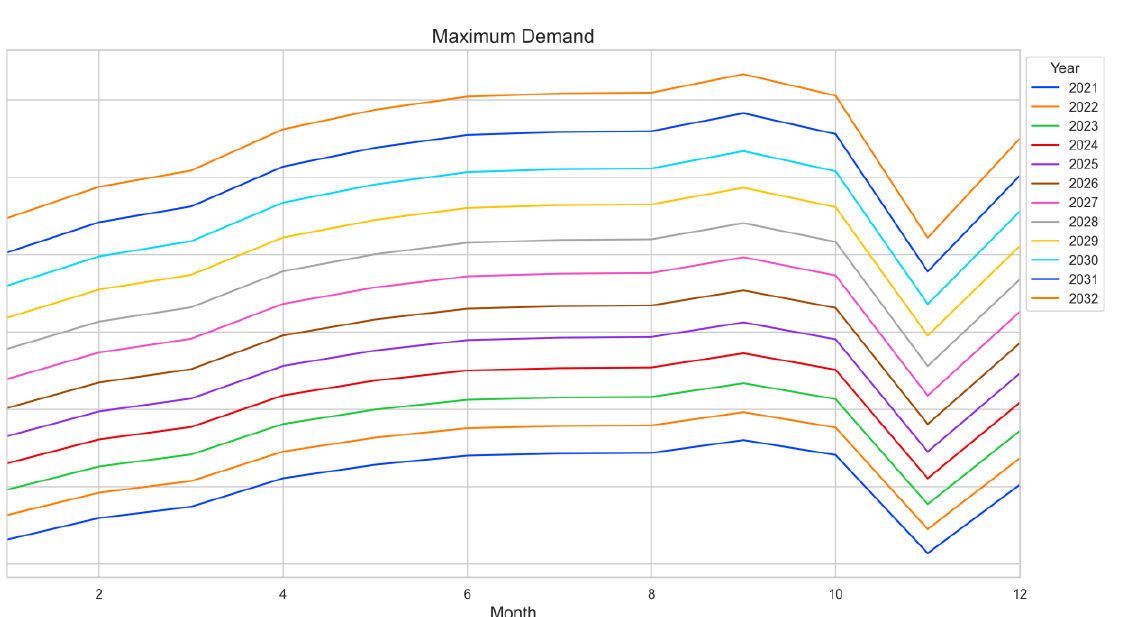
Figure 9. Growth of demand considering a low-projection future from 2017 to 2030. 5. Results and Discussion In the Quasi-dynamic simulations, the following behaviors were identified: Transmission lines reduced their load capacity by approximately 2.99%, which can be extrapolated to all of the regional lines. The evolution of the transmission line with the highest average load in the analysis period can be seen in Table 6. The southern region of